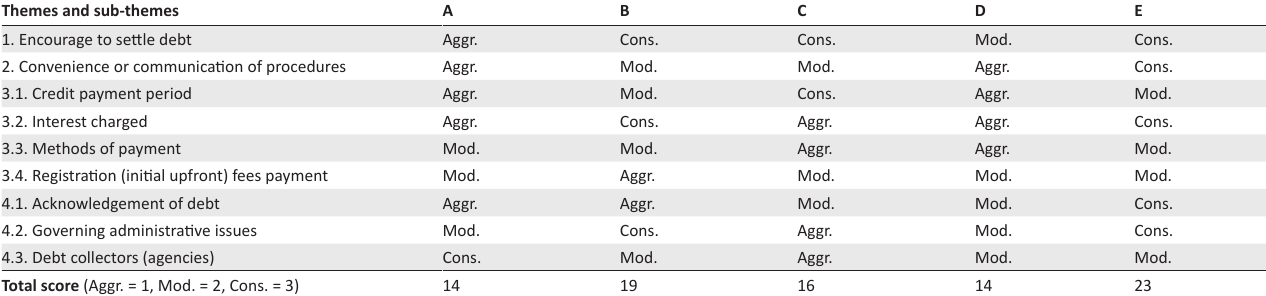
TABLE 2: Summary of document analysis and rating of the universities of technology. Themes and